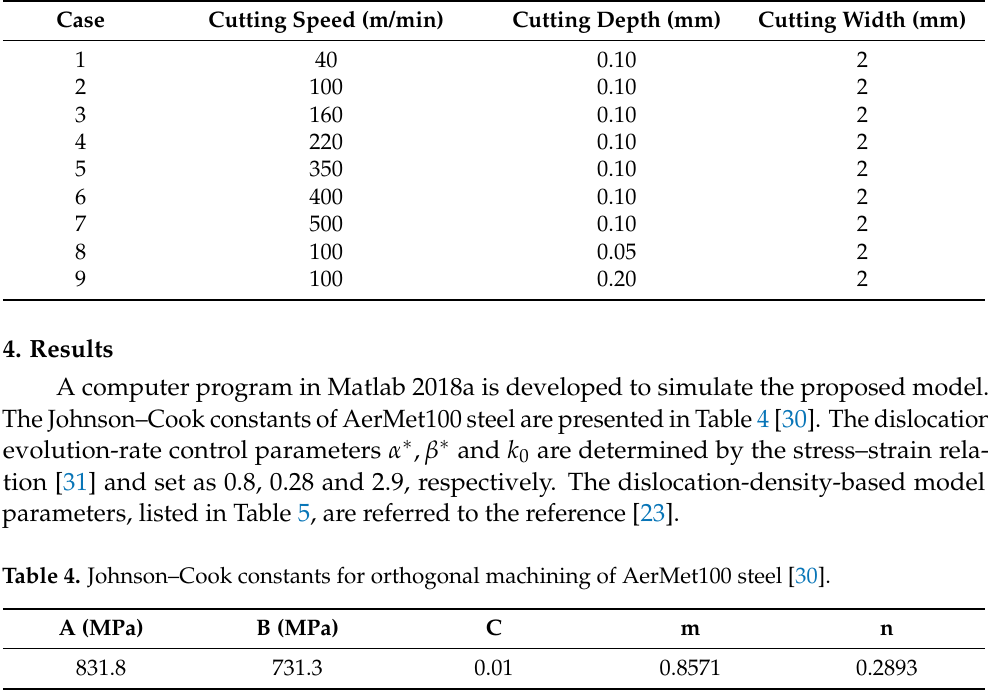
Table 3. Machining parameters for orthogonal cutting.